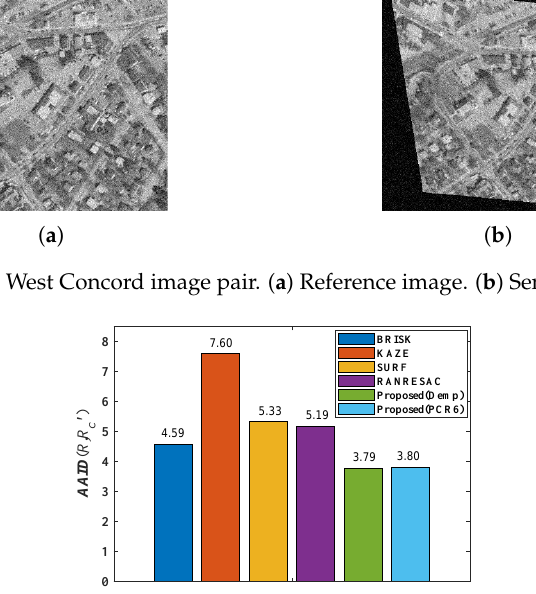
Figure 15. AAID evaluations of registration results for West Concord image